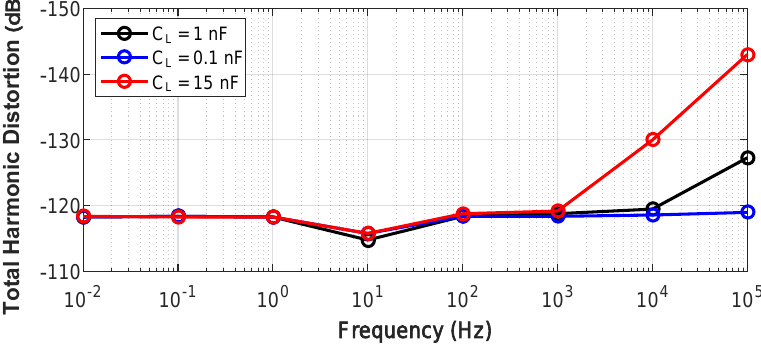
Figure 19. Simulated total harmonic distortion of the proposed amplifier with 0.1-nF, 1-nF and 15-nF load